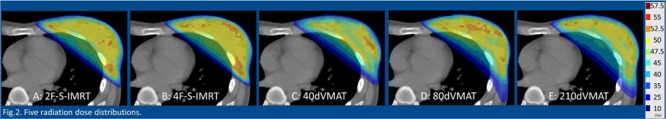
Dose distribution of the five treatment plans.